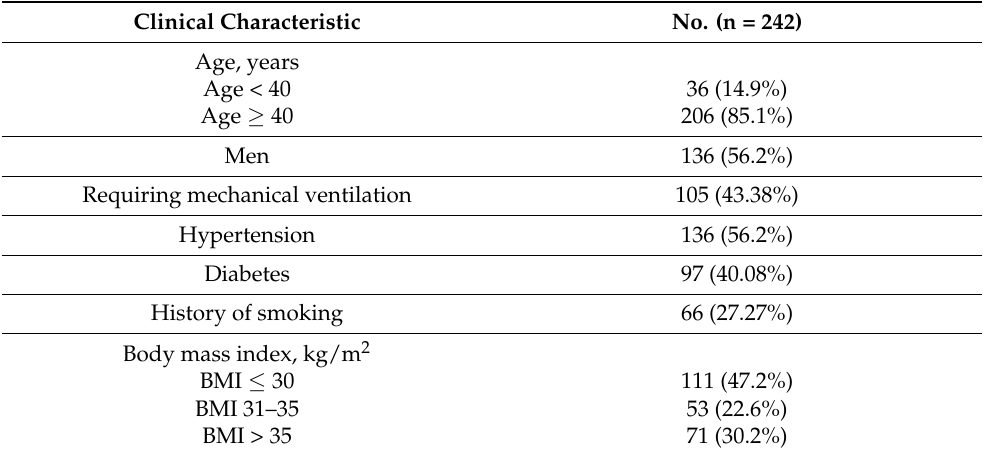
Table 2. Clinical characteristics of patients with COVID-19 of Cohort #2 (soluble E-Selectin) No. = number, BMI = Body mass